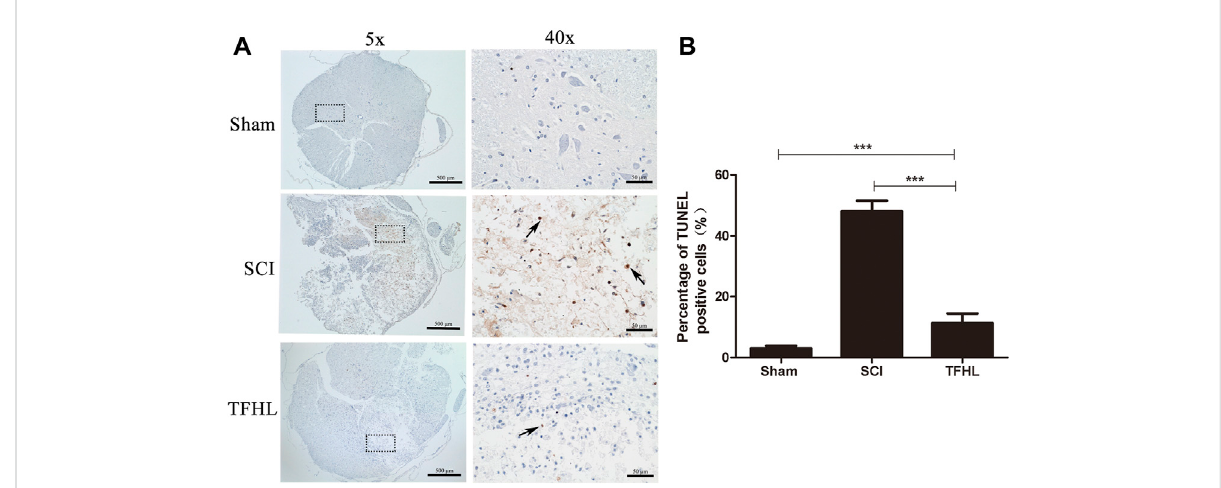
FIGURE 4 TFHL suppresses cell apoptosis in injured spinal cord tissues. (A) Observation of cell apoptosis in spinal cord sections of each group by TUNEL staining( n =3,cross-sectionoftheT10segmentofspinal cord,scalebars:500and50 μ M).Underthemicroscope,tawnyrepresentsapoptoticcells inthespinalcordtissue.Theblackdashedboxinthe×5magni fi cationistheobservationsiteunder×40magni fi cation,andthearrowpointstoTUNEL positive cells. (B) The percentage of TUNEL positive cells was counted in the spinal cord tissues of each group. Notice the decrease in the percentage of TUNEL positive cells the in TFHL group compared to the SCI group. All data are expressed as the mean ± SD. Differences among groups were determined with one-way ANOVA followed by a least-signi fi cant difference post hoc test. * p < 0.05, ** p < 0.01, *** p <